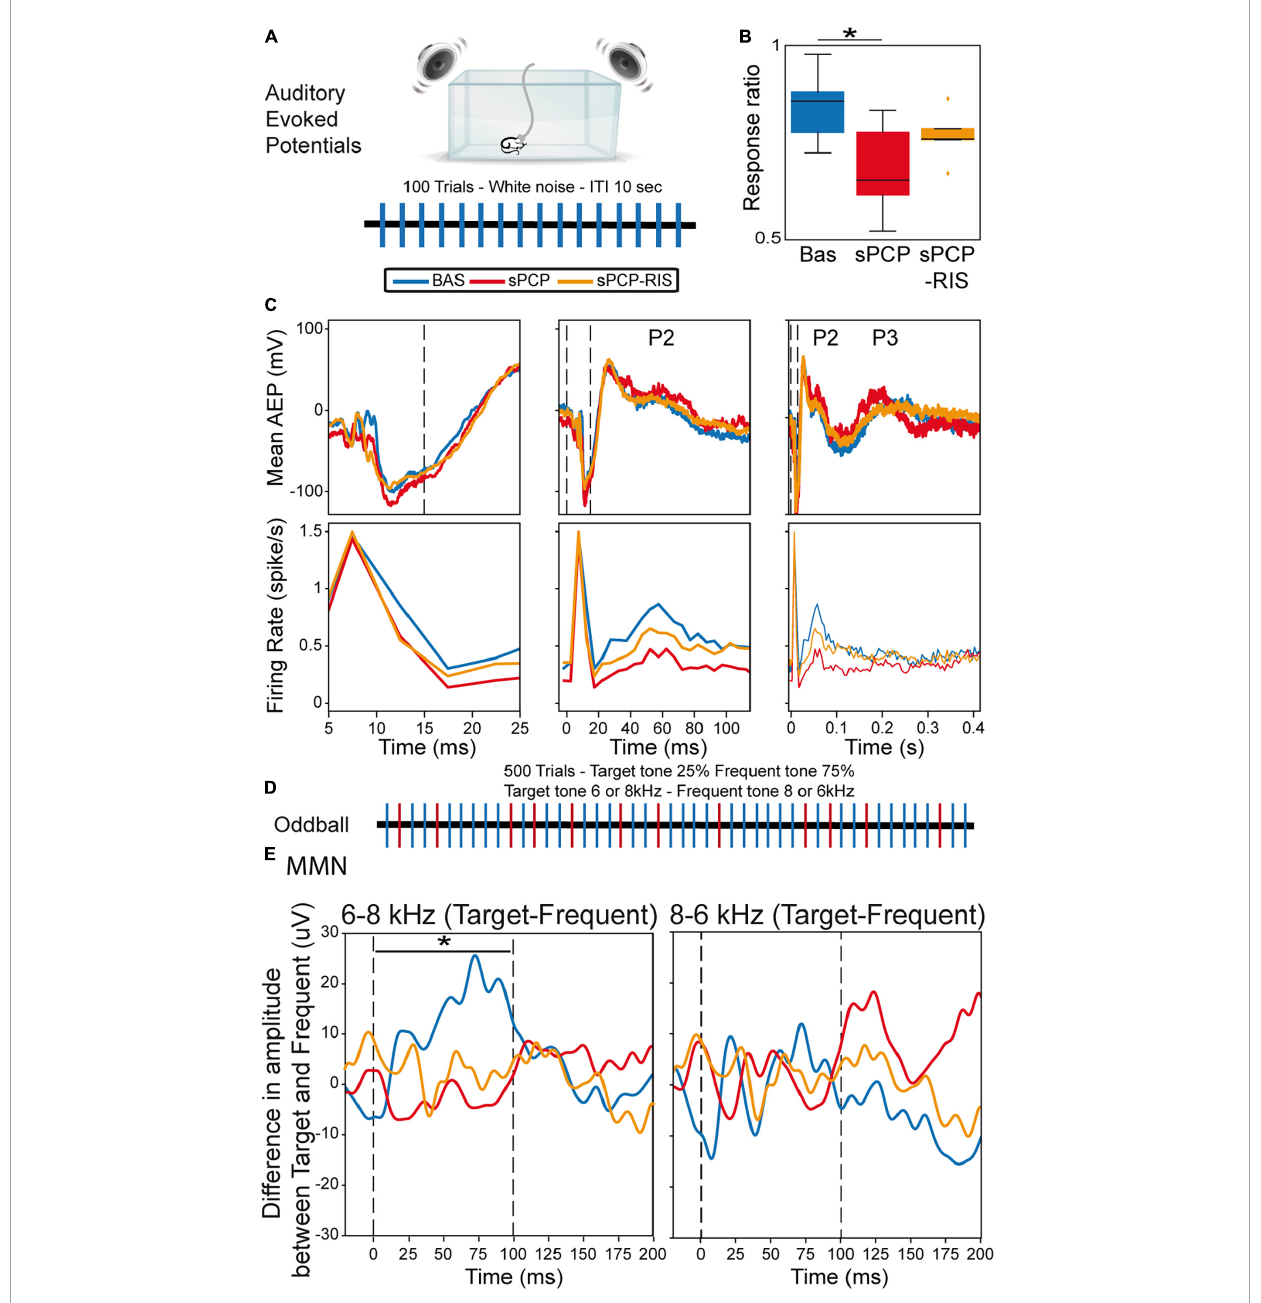
FIGURE6 Neural substrates of auditory processing in the prelimbic cortex and effects of sPCP and risperidone. (A) AEP protocol. (B) Ratio of AEP responses detected in the PFC after the auditory stimuli. The ratio decreased in sPCP-treated animals ([baseline vs. sPCP, sPCP vs. saline]: p = 0.024, 0.024, paired and unpaired t -test, respectively) and was partially recovered by risperidone. (C) Mean AEP and corresponding spiking activity (multi-unit firing rates) at three different timescales. P2 (40-70 ms) was associated with less spiking activity after sPCP ([baseline vs. sPCP, sPCP vs. saline as above]: p = 0.013, 0.068; paired and unpaired t -tests, respectively), whereas P3 (200–300 ms) was reduced in amplitude and spiking activity ([baseline vs. sPCP, sPCP vs. saline as above]: amplitude: p = 0.015, 0.055; firing rate: p = 0.024, 0.06). Risperidone increased the spiking activity associated within P2 with respect to sPCP ( F ( 2 , 10 ) = 2.49, p = 0.076; one-way repeated measures ANOVA) and augmented the amplitude and spiking activity associated with P3 component ([amplitude, firing rate]: p = 0.065, 0.097; paired and unpaired t -tests, respectively). (D) Protocol used for the oddball